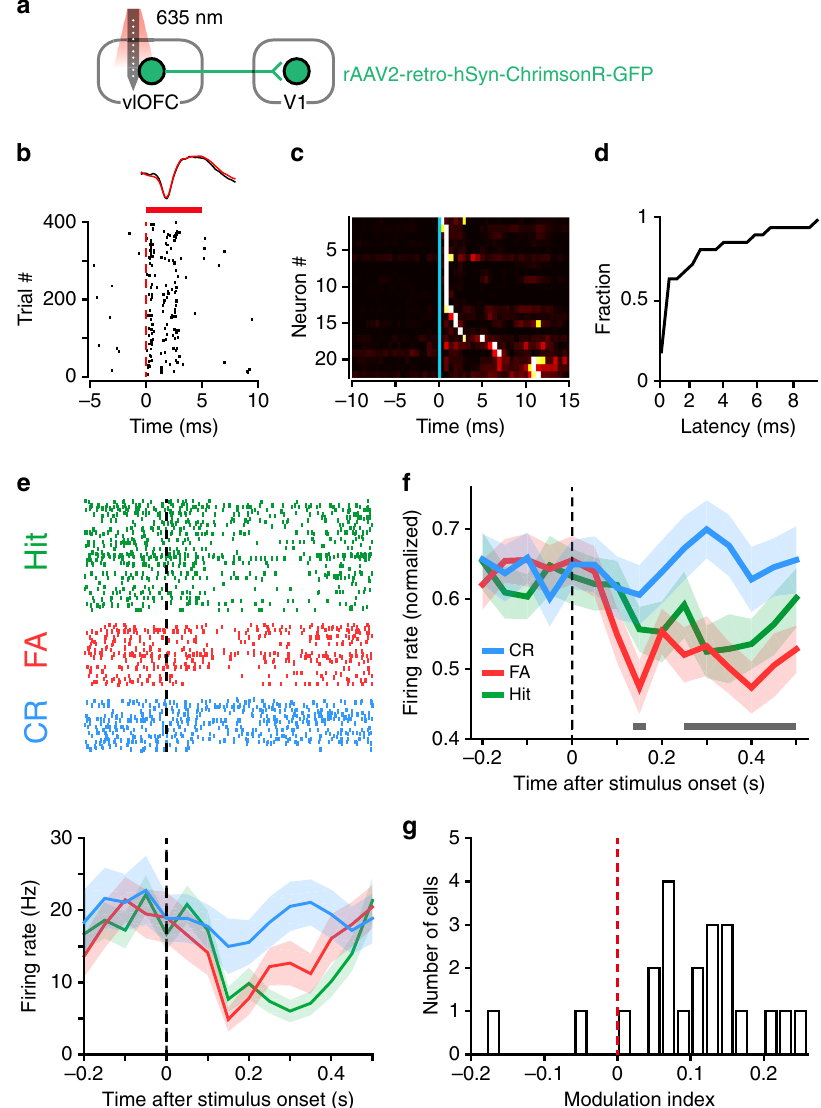
Fig. 5 V1-projecting OFC neurons reduce activity during reward expectation. a Schematic of the strategy for phototagging V1-projecting OFC neurons. b Spike raster of an identi fi ed V1-projecting OFC neuron aligned to laser onset. Red bar, duration of laser stimulation. Top, mean waveforms for spontaneous (black) and laser-evoked (red) spikes. c PSTHs aligned to laser onset (blue line) for all identi fi ed neurons. The responses were normalized by peak value and sorted by peak latency. Colors from black to white indicate increase in fi ring rate. d Cumulative distribution of laser-evoked spike latency for all identi fi ed neurons. e Spike rasters and PSTHs of an identi fi ed V1-projecting OFC neuron during hit (green), FA (red) and CR (blue) trials, aligned to stimulus onset. f The fi ring rates of each neuron were normalized by the maximum of the peak values in hit, FA, and CR trials, and were averaged across neurons. Horizontal bar, timepoints with P < 0.05, two-way repeated measures ANOVA F (1,21) = 17.86, P = 3.79 × 10 − 4 followed by Sidak ’ s multiple comparisons test. g Distribution of MIs for identi fi ed V1-projecting OFC neurons. P = 6.9 × 10 − 4 , n = 22 neurons, Wilcoxon two-sided signed rank test. For c – g , source data are provided as a Source Data fi le. Shadings, mean ±